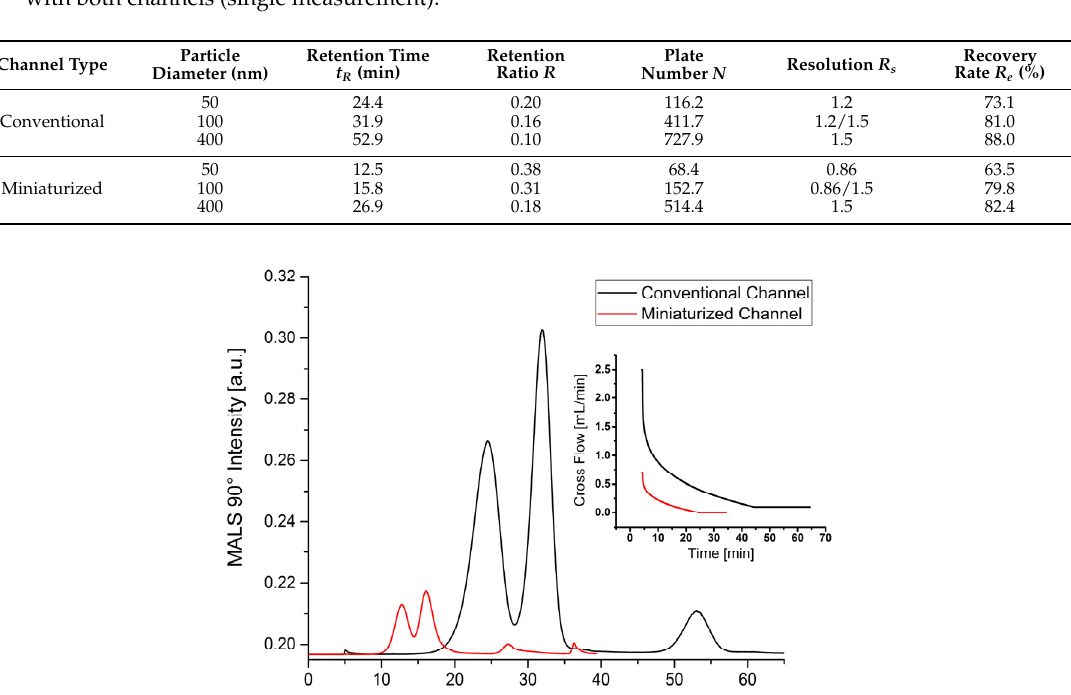
Table 6. Comparison of chromatographic parameters of a polystyrene nanoparticle mixture obtained with both channels (single measurement).